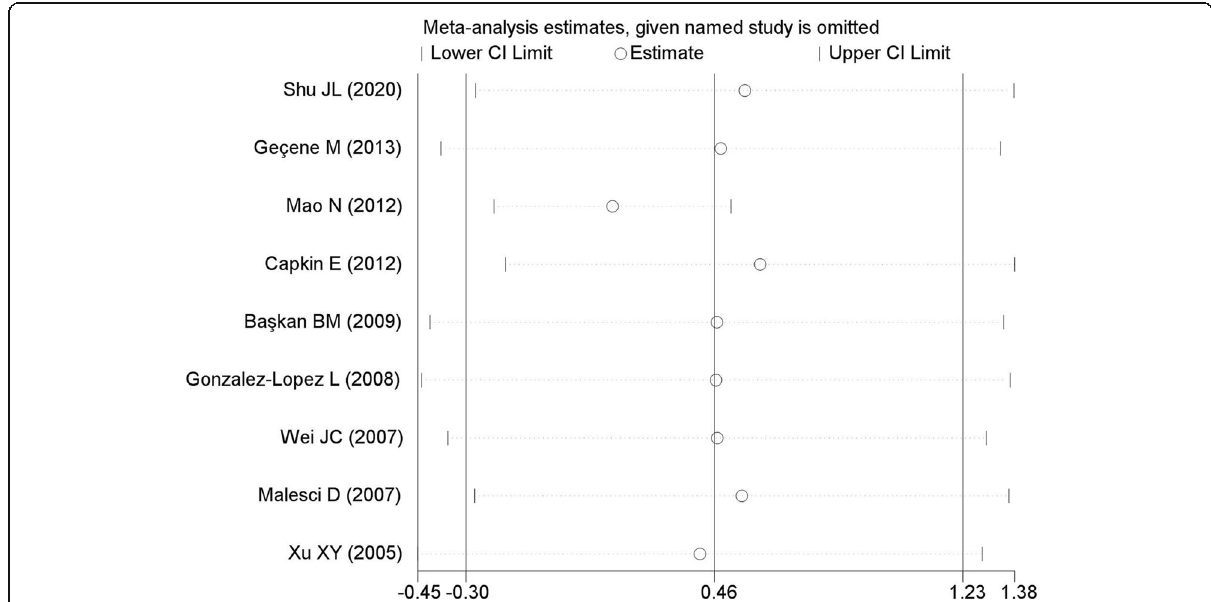
Fig. 2 Sensitivity analysis of the included studies. The two vertical axes, vertical middle axis, hollow circles, and two ends of the dotted lines respectively represent 95% confidence interval, overall odd ratio, pooled odd ratios, and 95% confidence interval